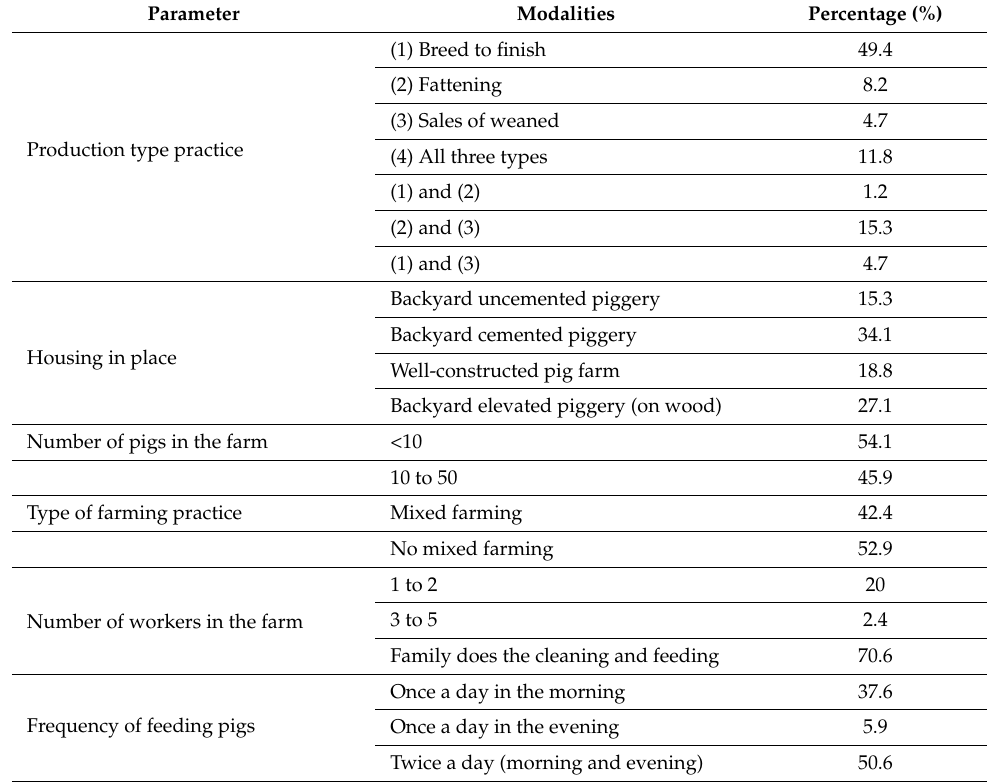
Table 3. Characteristics of the sampled